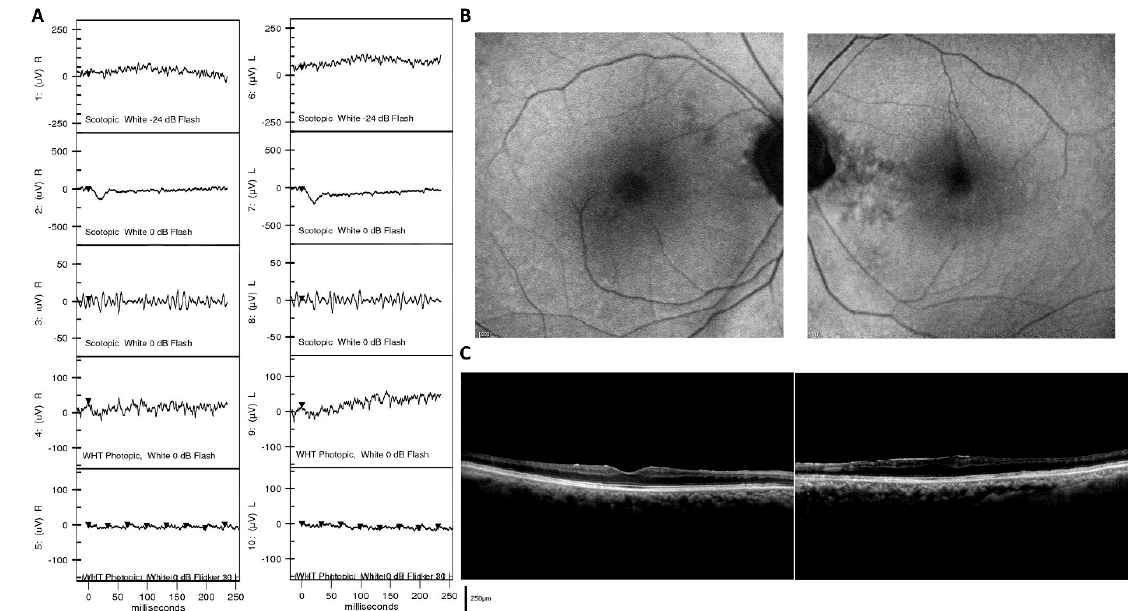
Figure 5. Multimodal images in a 79-year-old male patient with underlying hepatocellular carcinoma (HCC) presented with unexplanatory progressive vision loss and dim vision. ( A ) ffERG showed a severely attenuated response in both cones and rods. ( B ) Fundus autofluorescence did not reveal obvious retinal lesion or pathology. ( C ) OCT revealed generalized retinal thinning with central macular thickness 241 µ m in his right eye and 268 µ m in his left eye. HCC has a high prevalence in Taiwan, and this case demonstrated the possibility of HCC-related cancer-associated retinopathy (CAR).